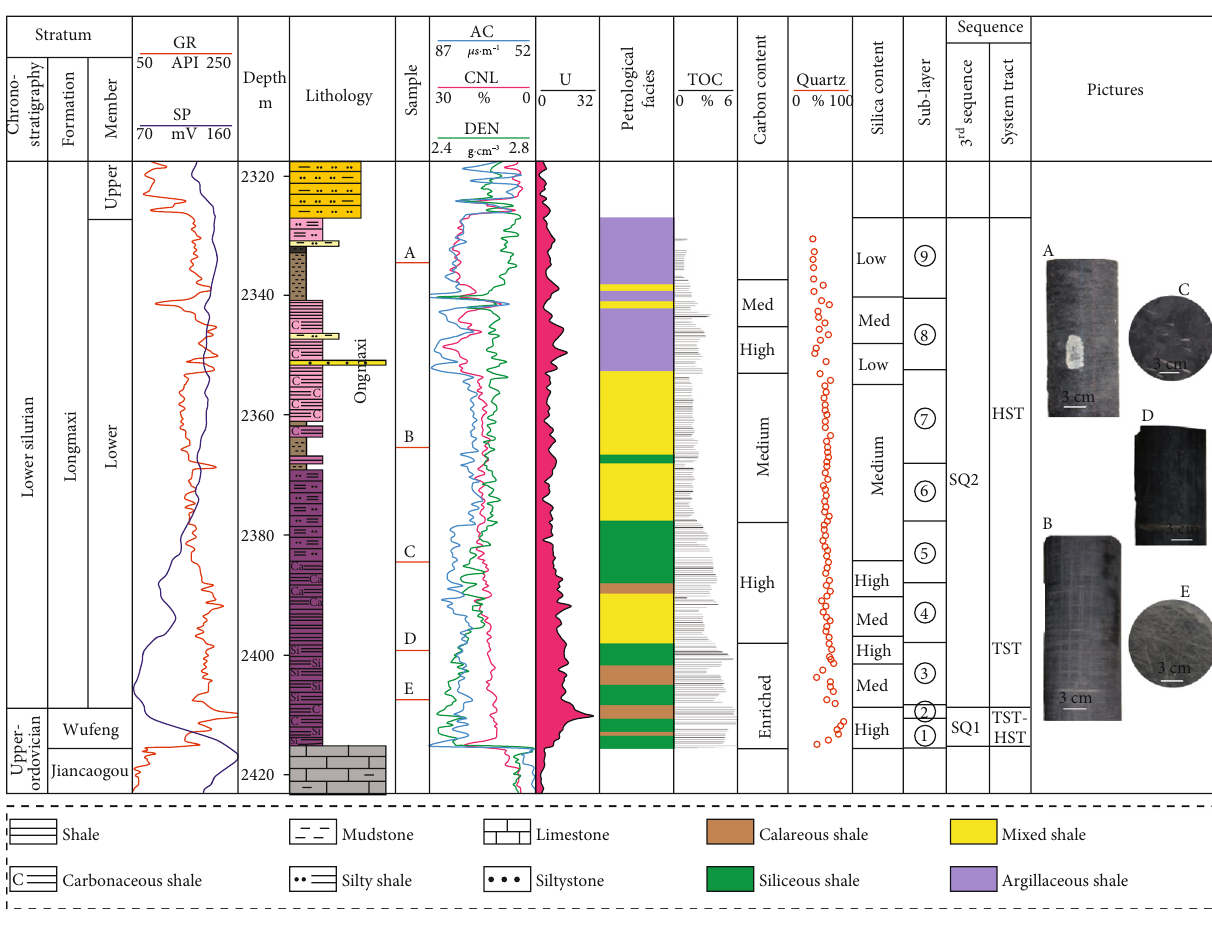
Figure 2: Histogram showing the division of lithofacies and sublayers in a typical pilot hole in the Fuling area. Modi fi ed from Refs. [29,